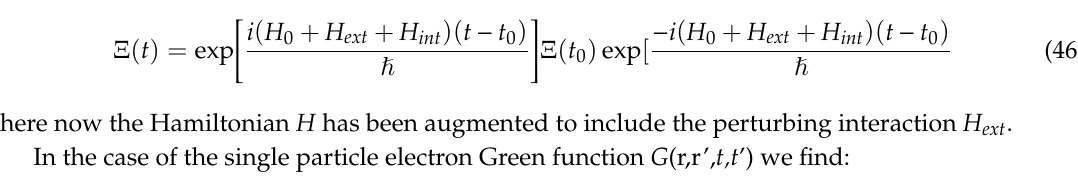
Figure 1. The Keldysh Contour. The general single particle Green function is the expectation value G( r , r ’,τ,τ’) ≡ − i < T Keldysh ψ ( r , τ ) ψ † ( r ’, τ ’ )> 0 eq where the time-ordering operator orders the field operators according to the temporal positions τ , τ’ on the Keldysh contour. The temporal values of τ , τ’ are denoted by the corresponding real times t, t’ . In the figure are shown the temporal positions and values for the “lesser” Green Function defined for all times τ on the upper branch (C − ), and for all times 𝜏′ on the lower branch (C + ), G < ( r , r ’,τ,τ’) ≡ − i < T Keldysh ψ ( r , τ ) ψ † ( r ’, τ ’)> 0 eq